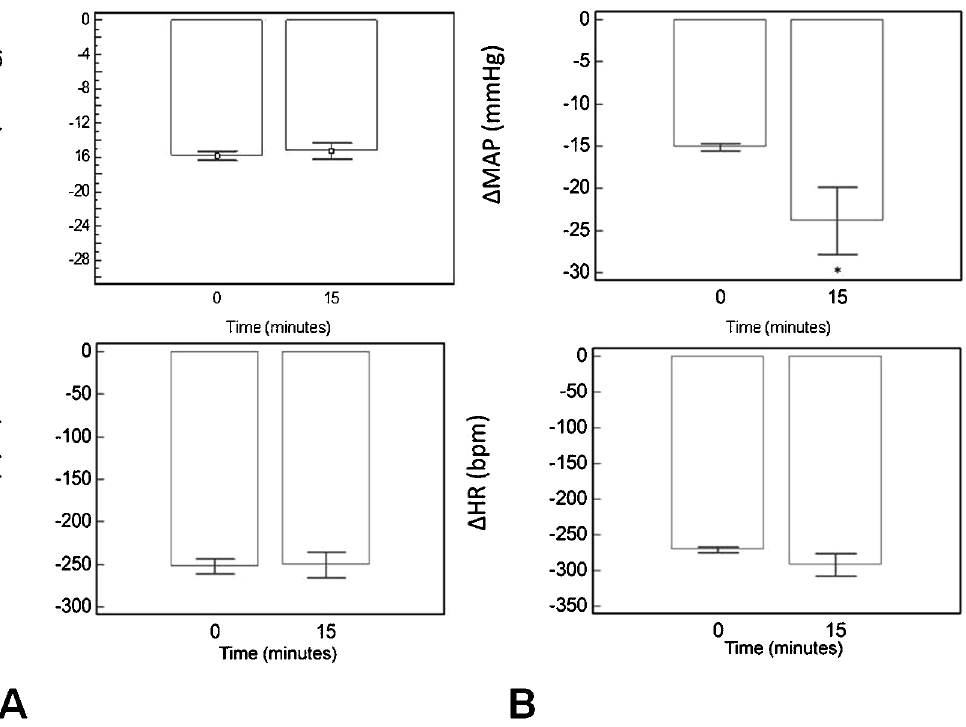
Figure 2 - Mean arterial pressure (MAP, mmHg) and heart rate (HR, bpm) responses elicited by activation of the cardiopulmonary reflex by i.v. PBG injections in the vehicle-treated (A, N=9) and groupATZ-treated groups (B, N=8) before (0 minutes) and 15 minutes after ATZ administration into the V4. *p , 0.05: different from control